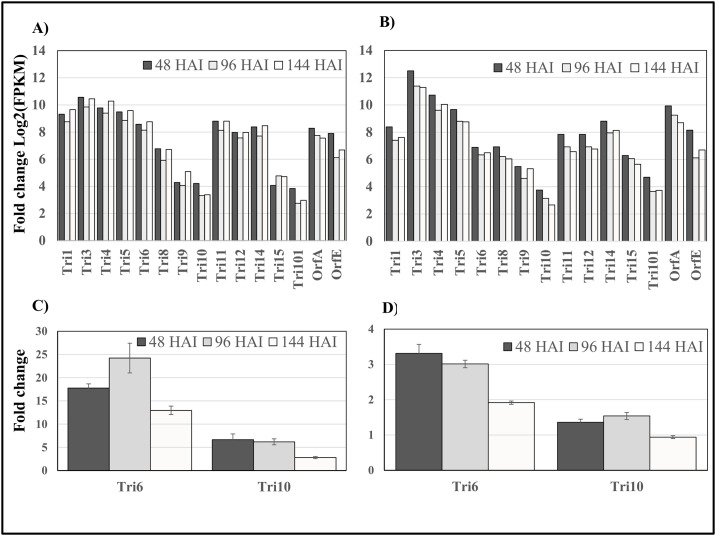
Fold change in expression of TRI genes during in planta infection compared to in vitro growth.A and B: Relative expression of Tri genes at the three infection points (48, 96, 144 HAI) compared to in vitro expression in 3ADON (A) and 15ADON (B) populations, respectively, based on RNA-seq analysis. Fold changes were measured using FPKM values, and were statistically significant at FDR <0.01. C and D: RT-qPCR validation of relative expression of Tri 6 and Tri 10 in planta compared to in vitro in 3ADON (C) and 15ADON (D) populations. Relative expression levels of the Tri genes were normalized using the beta-tubulin gene as internal control, and were calculated as the fold change by comparison between in planta and in vitro (axenic culture) samples. Error bars represent the standard error of means.